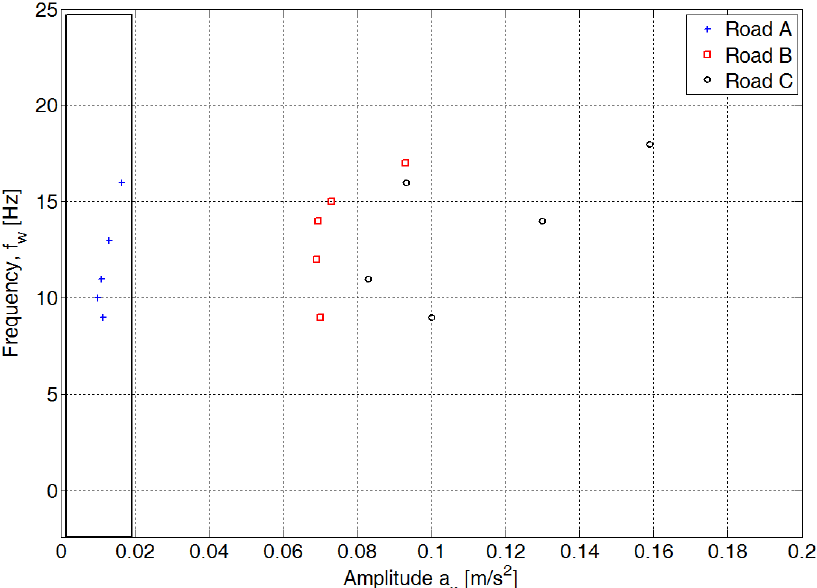
Figure 15. Limit value of longitudinal acceleration of the car body for which the condition of the road surface is classified as good.